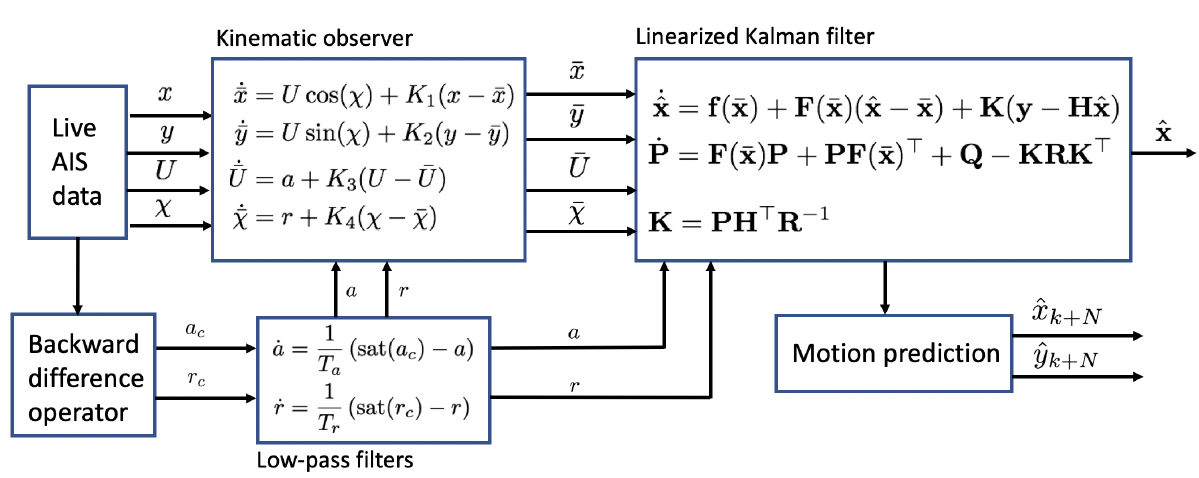
Figure 3: Signal flow of the eXogenous Kalman